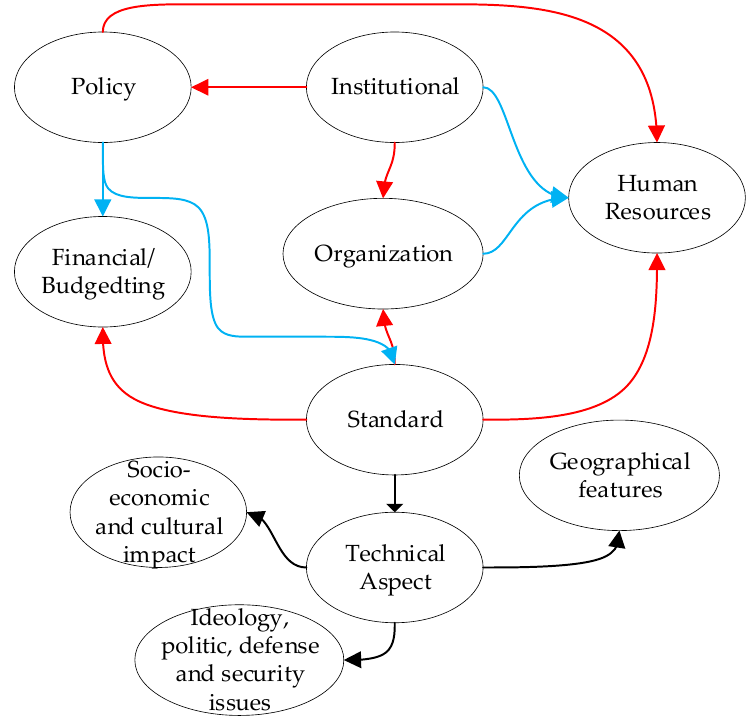
Figure 2. Fuzzy cognitive map of (participatory) toponyms handling in the Indonesian case study (blue line: support, red line: challenge, black line: regular relationship).